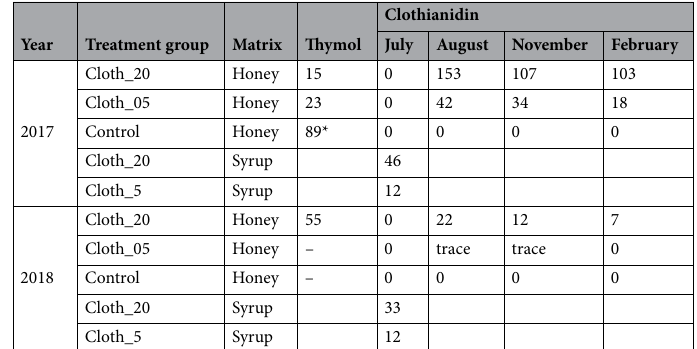
Table 4. Concentrations of clothianidin and thymol in honey and syrup samples across treatment groups for the two experiments in Arizona. Values are parts per billion. *Trace amounts of 2,4-DMPF were also detected.